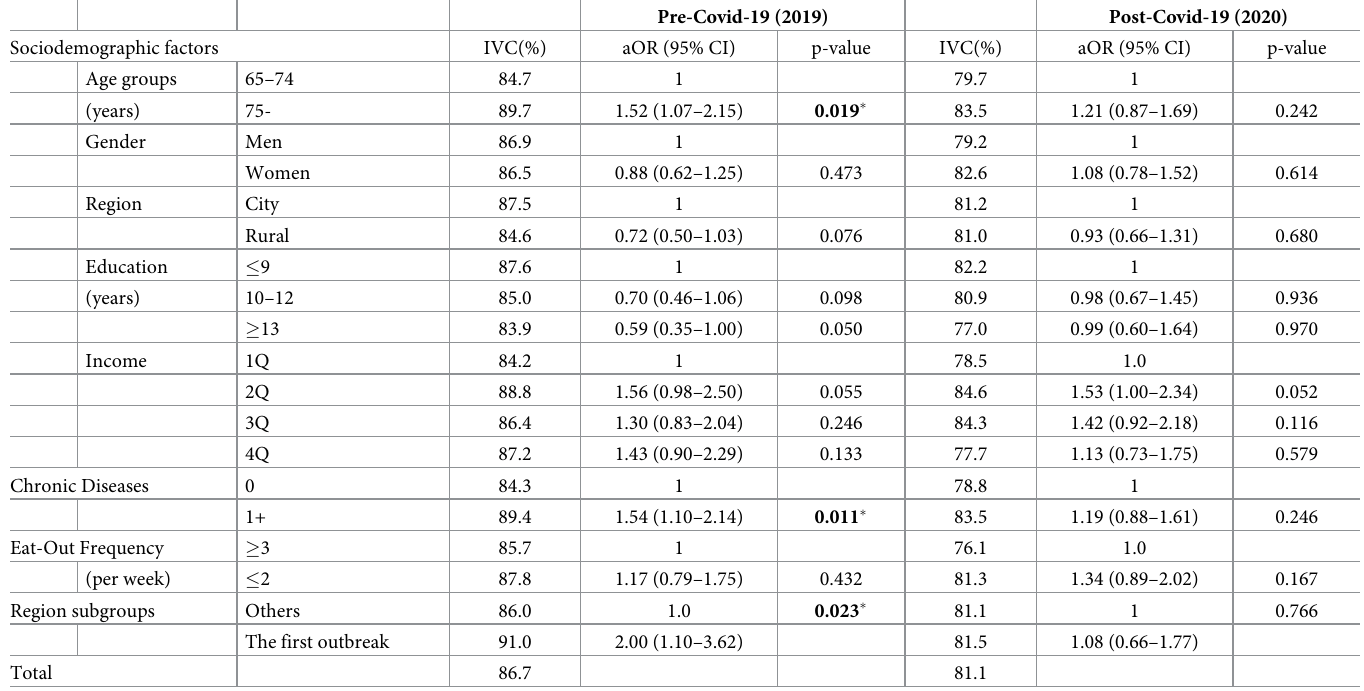
Table 4. Comparison of influenza vaccination coverage between pre- and post-Covid-19 pandemic among 65 years or